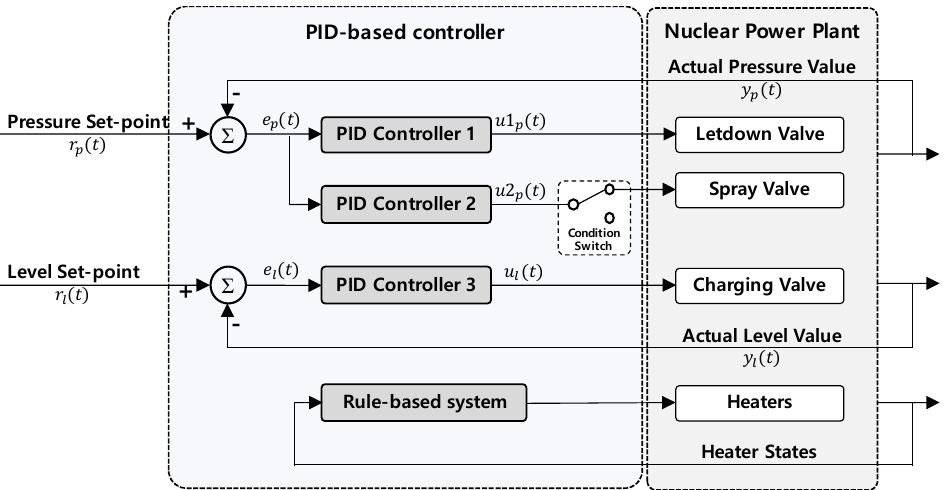
Figure 14. PID-based system block diagram.